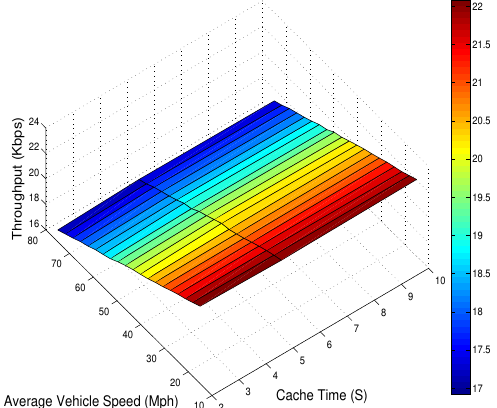
Figure 7. Throughput vs. 2 s, 5 s, 10 s Cache Time and Average Vehicle Speed (Mph).